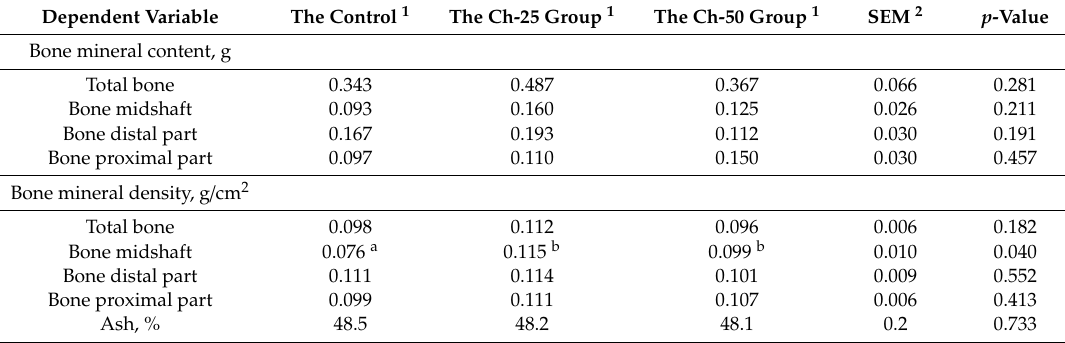
Table 5. Densitometric parameters of tibia of 16-week-old male